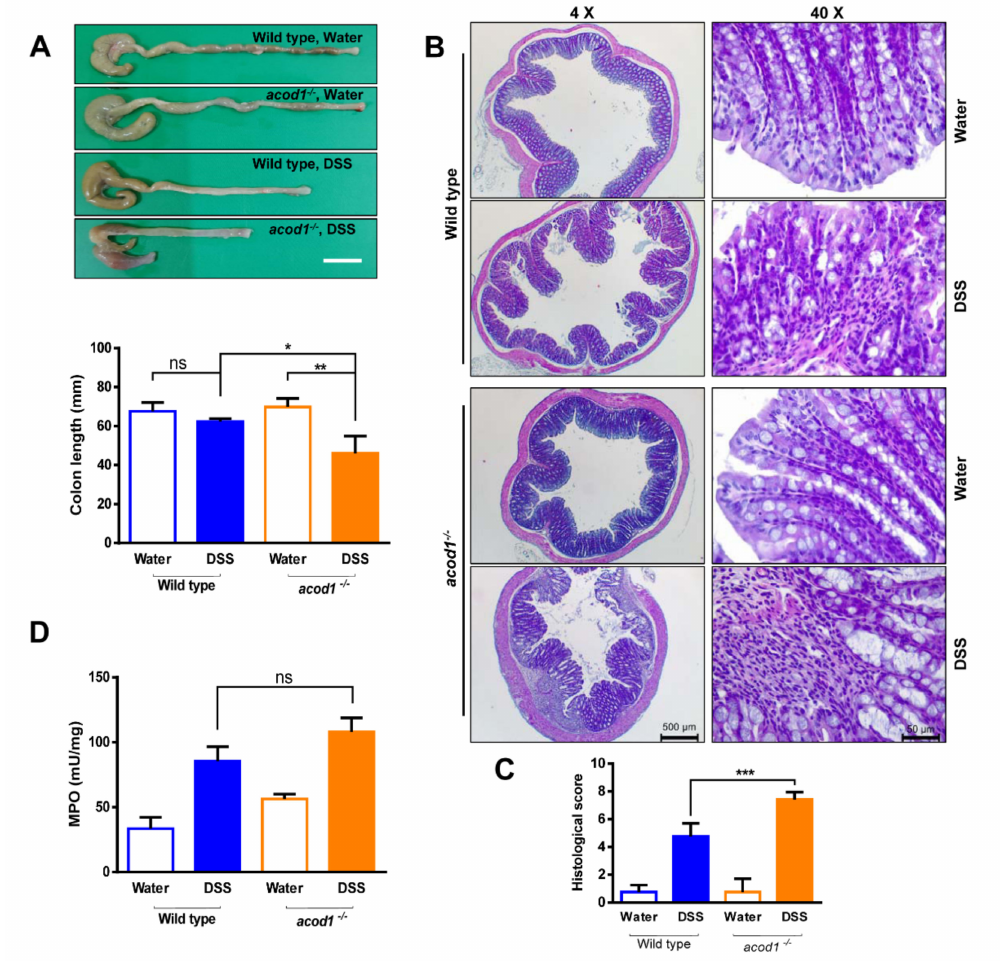
Figure 2. Acod1 gene deficiency aggravated colon contraction induced by DSS. ( A ) Representative images of colons isolated from WT and acod1 − / − mice treated with regular water or 2.2% DSS for 7 days. The colon lengths in each group were measured at 7 days (n = 6–8). * p < 0.05 WT+DSS versus acod1 − / − + DSS. ** p < 0.01 acod1 − / − versus acod1 − / − + DSS. ( B ) Representative histopathological images of colon tissue sections from water- and DSS-treated WT and acod1 − / − mice. Left panel images taken using 4 × objective on an H&E-stained tissue section (Scale bar: 500 um). Right